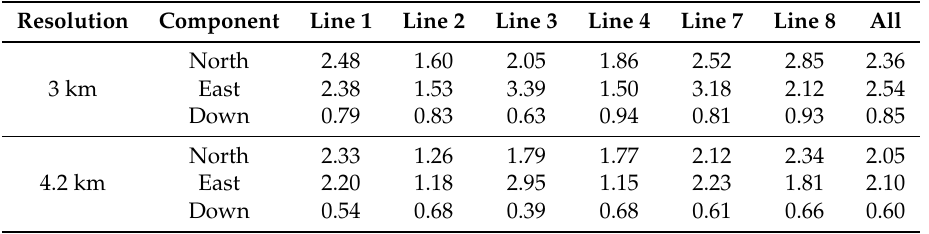
Table 6. Repeatability in different resolutions